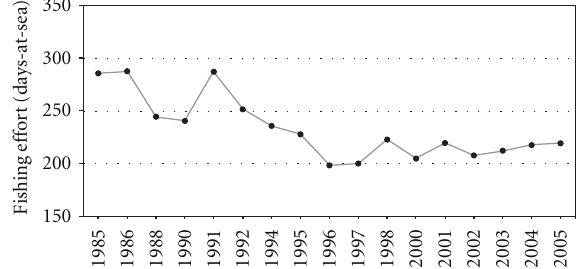
Figure 3: Fishing e ff ort expressed in terms of the number of workdays in the north-western Ionian Sea from 1985 to 2005.